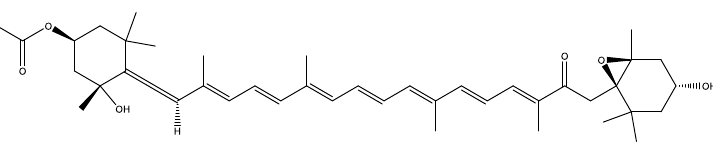
Figure 4. Chemical structure of fucoxanthin.